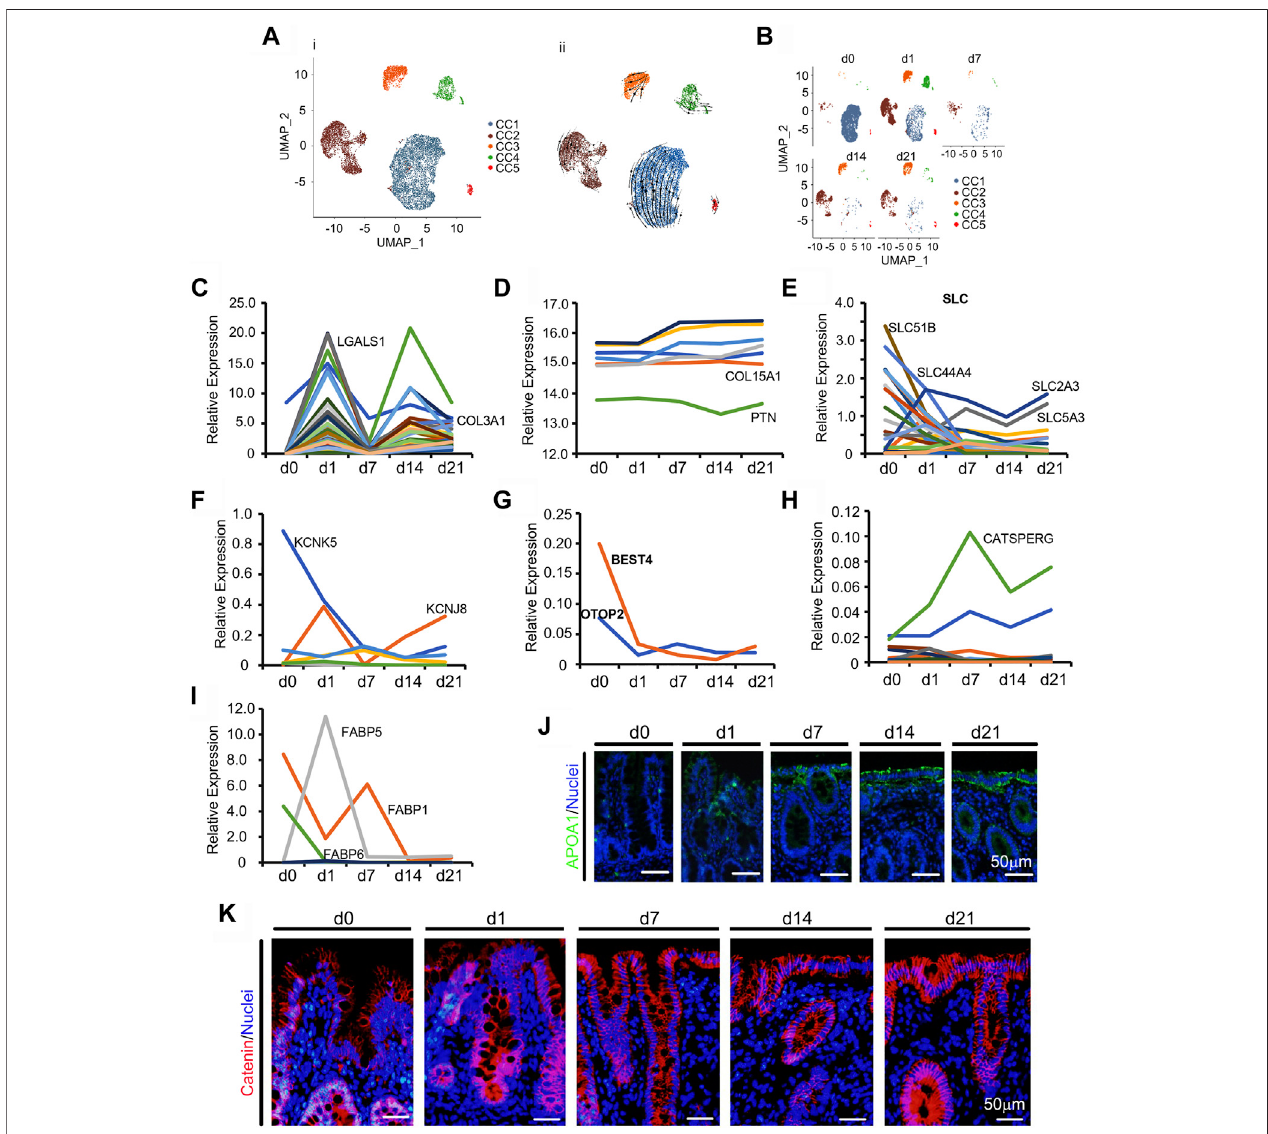
FIGURE3| Differentiationofpigletcecalenterocytes(CC)duringtheneonatalwindow. (A) CelltypeclustersforCCforthecellstogetherfromthe fi vetimepointsby UMAP: CC1 to CC5. (i) UMAP of CC single cells (points), colored by cluster assignment. (ii) RNA velocity vector projection on UMAP plots (The arrow indicated the developmental trend). (B) CC population changesduring development(fromd0 tod21). (C) The relative expression patternofthe top50speci fi cally expressed genesin CC. The gene level was based on the expression of each gene in all the cell, and it is relative level from scRNA-seq analysis. The Y-axis presents the relative expression, and X-axis shows the time points. (D) The relative protein levels of some of the top 50 speci fi cally expressed genes from the proteomic analysis. The Y-axis presents the relative expression, and X-axis shows the time points. (E) The relative expression pattern of solute carrier family genes. The gene level was based on the expression of each gene in all the cell, and it is relative level from scRNA-seq analysis. The Y-axis presents the relative expression, and X-axis shows the time points. (F) The relativeexpression pattern ofpotassium channel subfamily genes. The gene level wasbased on the expression ofeach genein all the cell, and itisrelativelevel from scRNA-seq analysis. TheY-axis presents therelativeexpression, and X-axis shows thetime points. (G) Therelative expression pattern ofBEST4 and OTOP2. Thegene level was based on the expression of each gene in all the cell, and it is relative level from scRNA-seq analysis. The Y-axis presents the relative expression, and X-axis showsthetimepoints. (H) Therelativeexpressionpatternofcationchannelfamilygenes.Thegenelevelwasbasedontheexpressionofeachgeneinallthecell,anditis relative level from scRNA-seq analysis. The Y-axis presents the relative expression, and X-axis shows the time points. (I) The relative expression pattern of fatty acid bindingprotein family genes.Thegenelevel wasbasedontheexpression ofeach geneinallthecell, anditisrelativelevel fromscRNA-seq analysis.TheY-axis presents the relative expression, and X-axis showsthetime points. (J) Proteinlevels ofAPOA1 inthedifferent samplesat different time pointsaccordingtoIHF. Scalebar: 50 μ m. (K) Protein levels of catenin in the different samples at different time points according to IHF. Scale bar: 50 μ m.